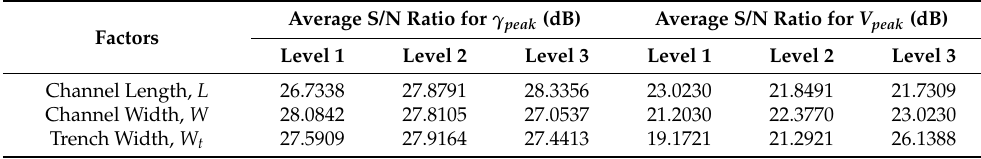
Table 5. Calculated average S/N ratio for each level of the control factors.